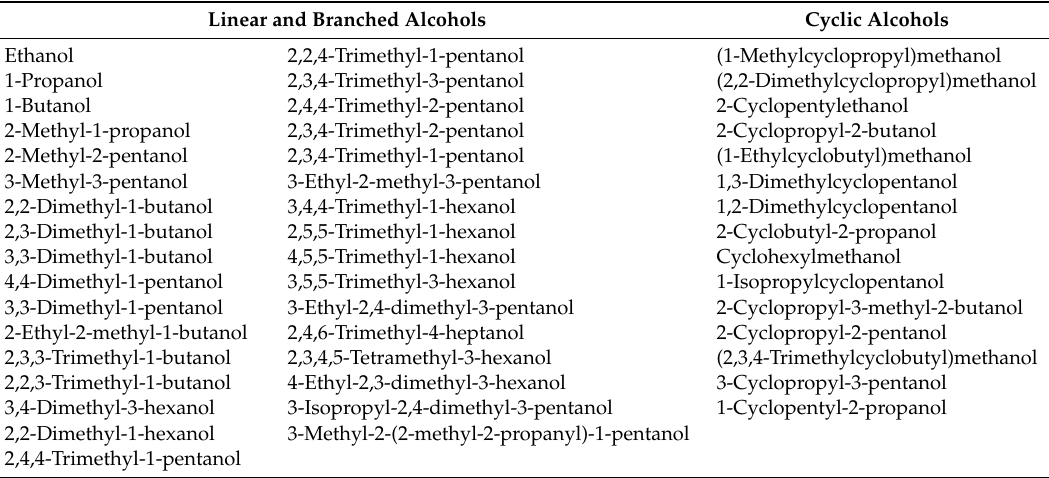
Table 3. Alcohols with potential to be blended at low (up to 15%) range in gasoline (Scenario 1). Linear and Branched Alcohols Cyclic